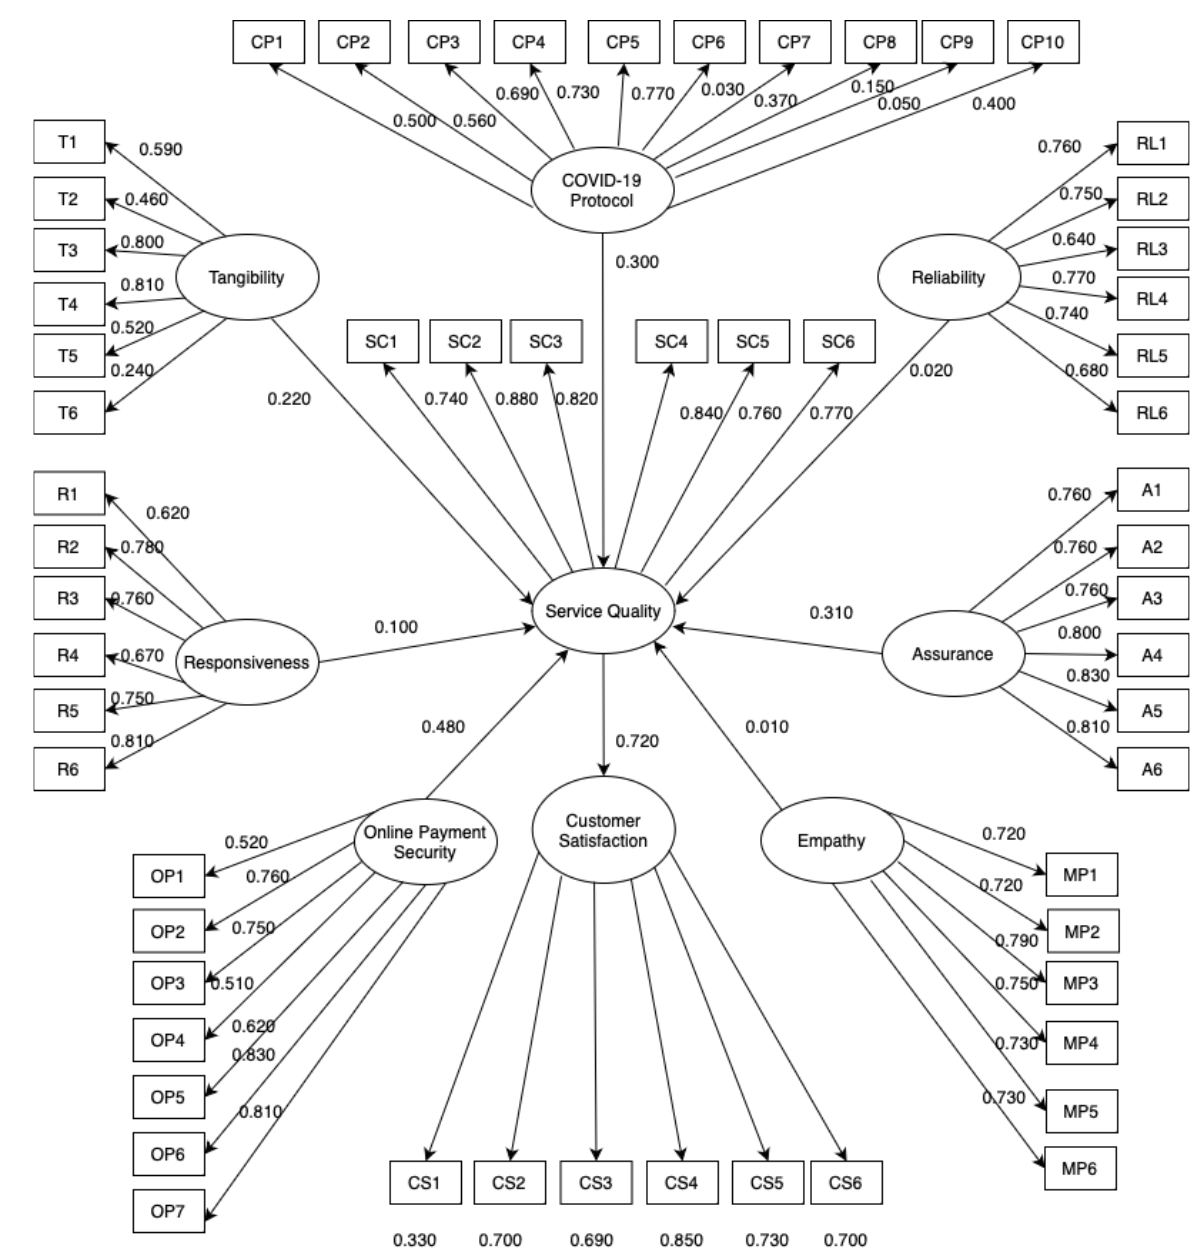
Figure 4. Initial SEM with indicators for evaluating service quality.